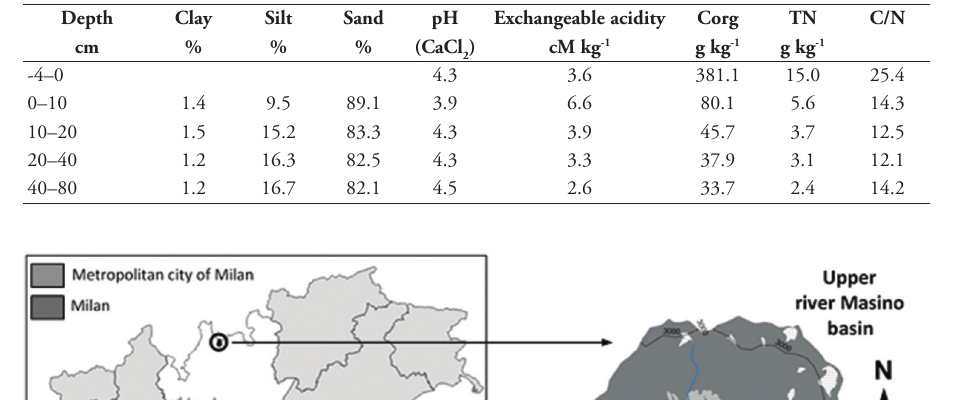
Table 1. Soil properties of soil collected at Val Masino study